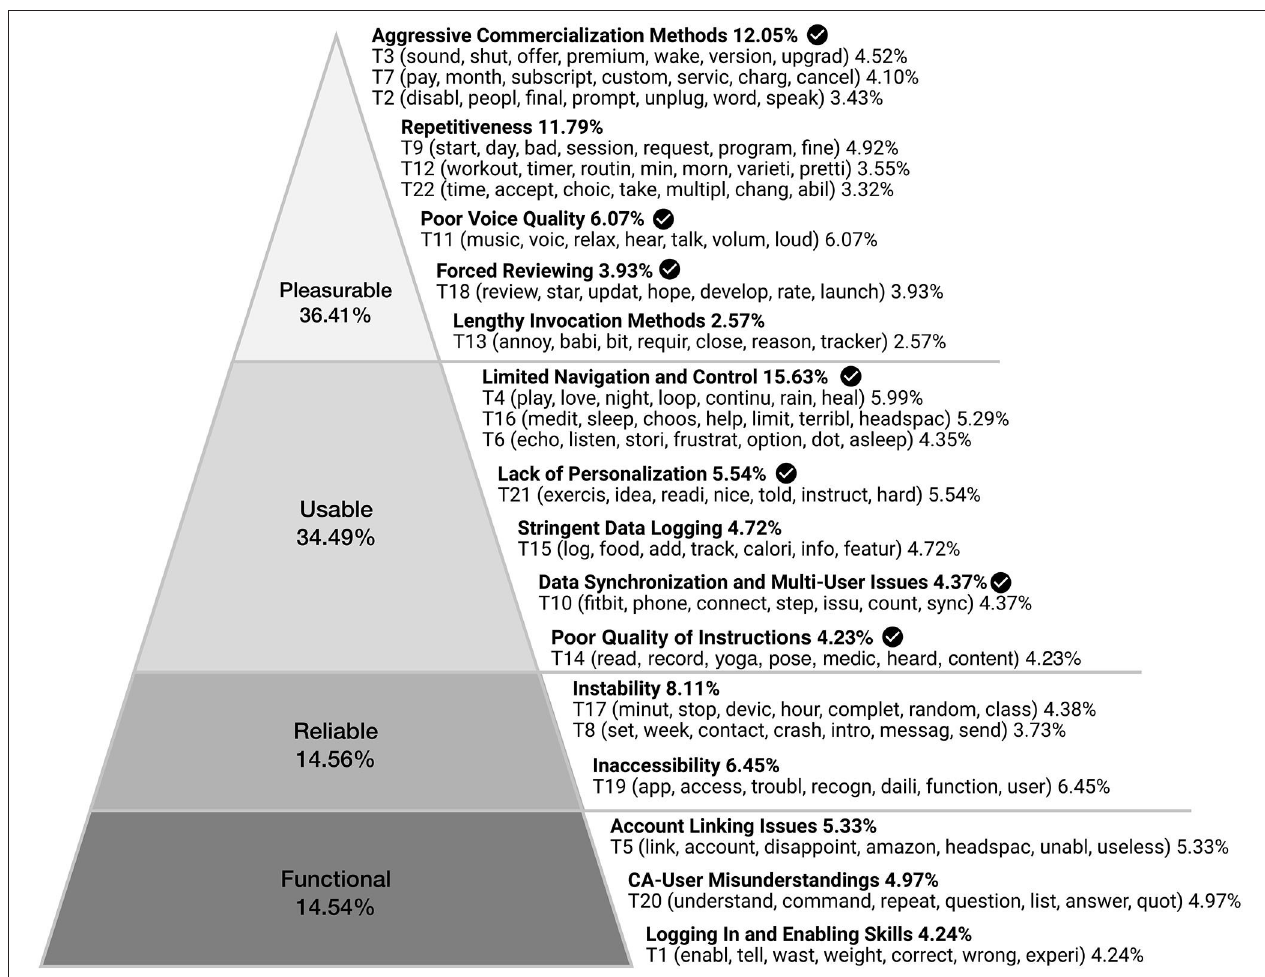
FIGURE 3 | Subjects of criticism of Alexa Skills designed to support wellbeing, grouped within Aarron Walter’s hierarchy of user needs (30). Each subject of criticism contains one or multiple topics [T#] generated by STM. The words in parenthesis are the 7 highest probability words of the respective topic. The percentages show the proportion of the reviews. Check mark indicates the topics that have been discussed in prior work by Shin et al. (